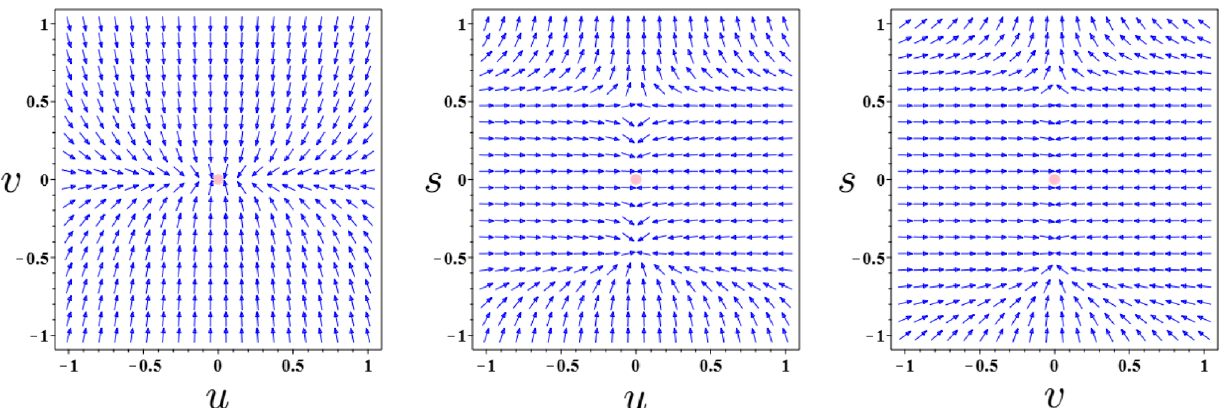
Fig. 4 This figure indicates three different Poincaré sections of the phase portrait of the system (131)–(133). In plotting these diagrams, we have assumed m 3 = 1, A = 2 / 3, and B = − 1. The pink points show the critical